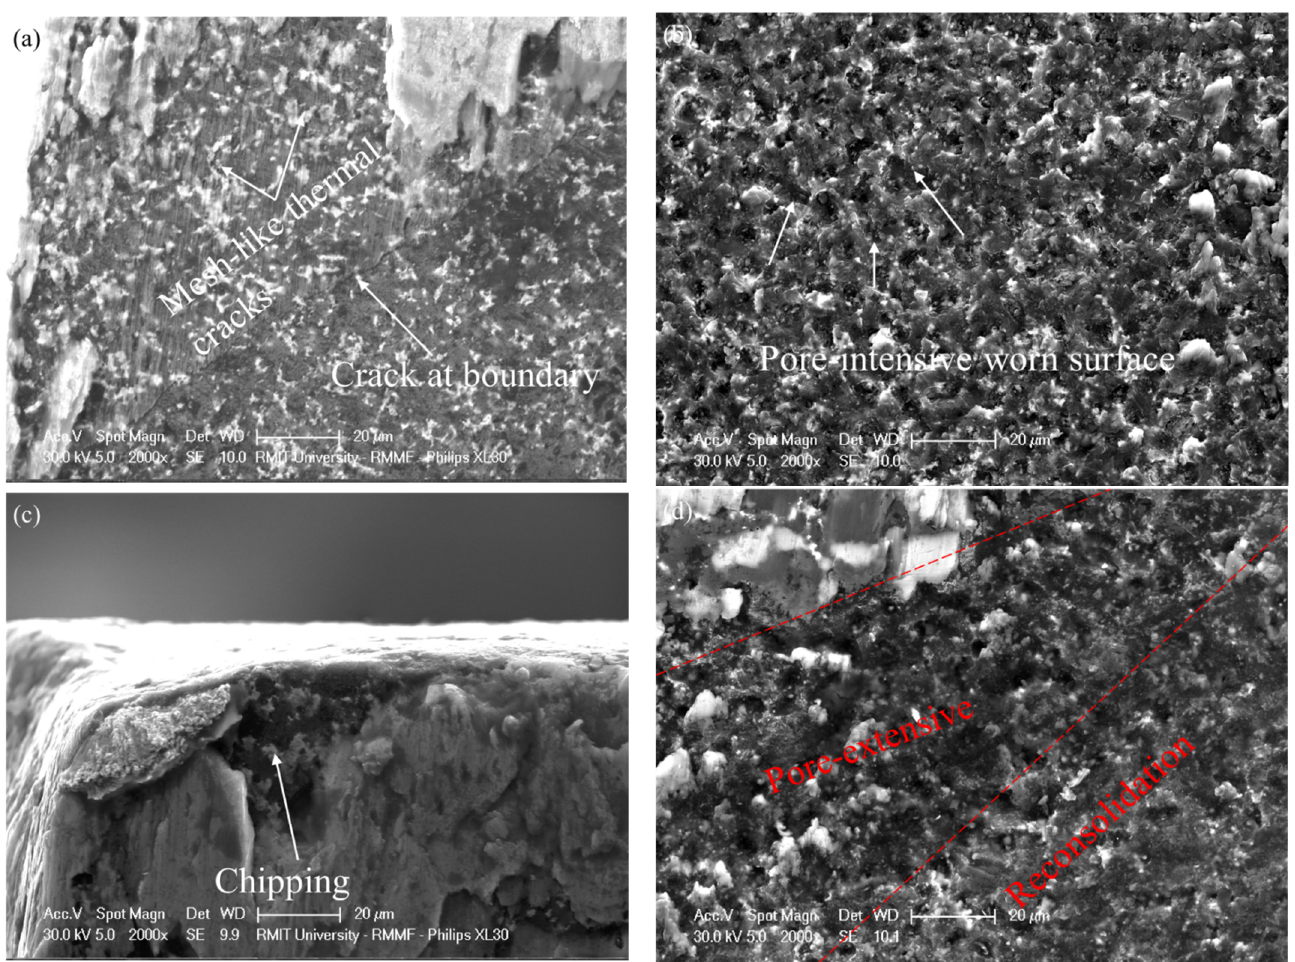
Figure 11. Micro-morphology of the regions II on the worn surface of different PCD tools: ( a ) 002A, ( b ) 002E, ( c ) 302A, and ( d ) 302E.